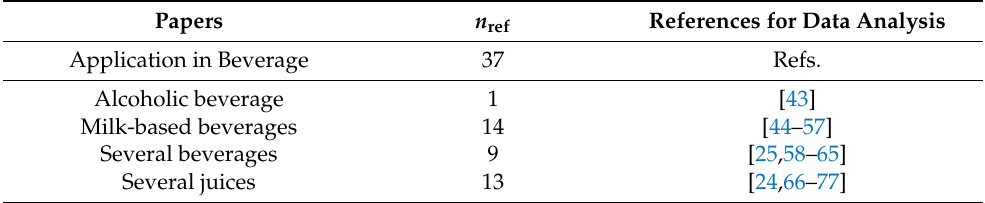
Table 2. Application of mixture design in the beverage.